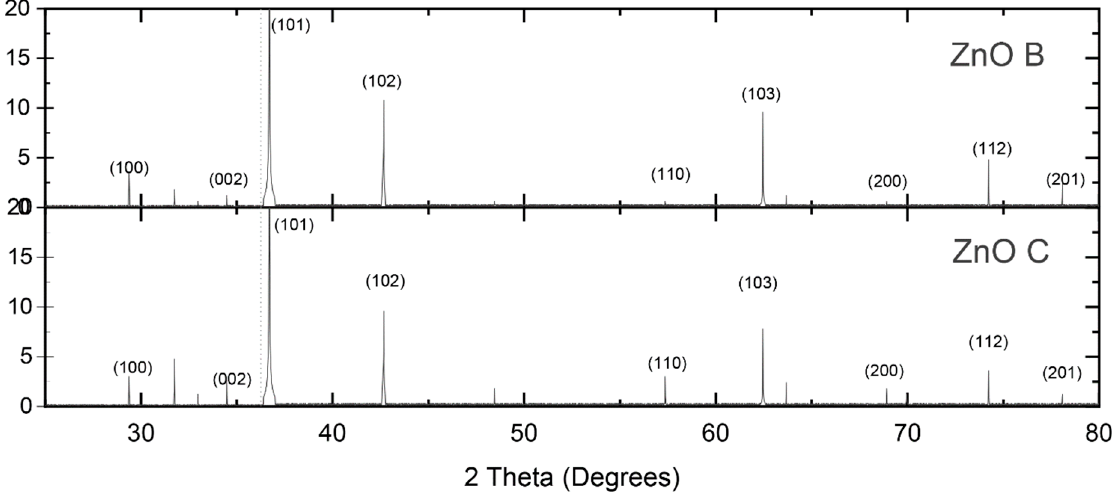
Figure 1. Di ff ractogram of ZnO samples showing zincite crystallization. Figure 1. Diffractogram of ZnO samples showing zincite crystallization. Table 2. Crystallite sizes measured by the Scherrer equation and surface areas measured by the